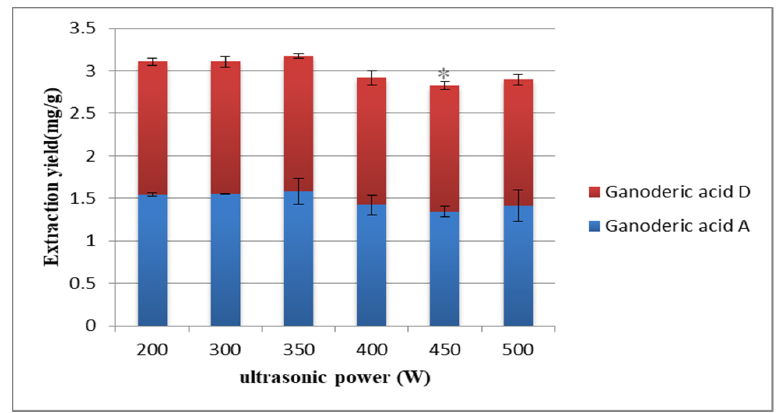
Figure 5. Effect of ultrasonic power on the extraction yield. Compared with 350 W group: * p < 0.05.